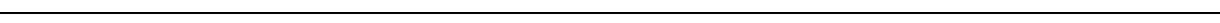
Fig. 5 PR130 upregulation by MS-275 represses checkpoint kinase signalling. a HCT116 cells were stimulated with 1 mM hydroxyurea (HU) and/or 2 µ M MS-275. Wedges signify increasing incubation times (6, 10 and 14 h). Asterisks signify pre-incubation with MS-275 for 1 h. Indicated (phosphorylated) proteins were analysed by western blot. Vinculin served as loading control. b HCT116 cells were cultured with 2 µ M MS-275 and/or 1 mM HU for 24 h and incubated with the PP2A inhibitor ocadaic acid (25 nM) for additional 4 h. Phosphorylated forms of ATM, CHK1 and mSIN3A (loading control) were detected by immunoblot. Numbers indicate densitometric analysis of western blot signals relative to HU-treated samples and normalised to loading control. c Relative mRNA levels of PPP2R3A in HCT116 cells evaluated by quantitative RT-PCR. Cells were treated with 1 mM HU and/or 2 µ M MS-275 (6 – 24 h). Results show the mean ± SD ( n = 3; one-way ANOVA, *** P < 0.001; **** P < 0.0001). d Cells were cultured with or without increasing amounts of MS-275 (0.5; 1; 2; 5 µ M) alone or in combination with 1 mM HU for 24 h. Indicated proteins were detected by immunoblot. Densitometric analysis of PR130 signals is indicated relative to untreated cells and normalised to Vinculin levels ( n = 3). e Knockdown HDAC1 – 3 was performed with siRNAs by transient transfection for 48 h. 1 mM HU was added for further 24 h. PR130 was detected by immunoblotting, quanti fi ed relative to untreated siCtrl cells and normalised to mSIN3A levels (loading control). f ChIP was performed to detect acetylated histone H3 and the binding of HDAC1/HDAC2 to the PPP2R3A promoter in presence/absence of MS-275. Acetylation of histone H3 is set as 1. Results show the mean ± SD ( n = 3). g Cells were transiently transfected and treated as described in e . Indicated (phosphorylated) proteins were detected by western blot. h HCT116 cells were transfected with pcDNA3.1 or HA-PR130 for 48 h and treated with 1 mM HU and 2 µ M MS-275 for additional 24 h. Indicated proteins were detected by immunoblotting. Western blot signals were quanti fi ed relative to HU-treated cells and normalised to loading controls (Tubulin, Vinculin; n =